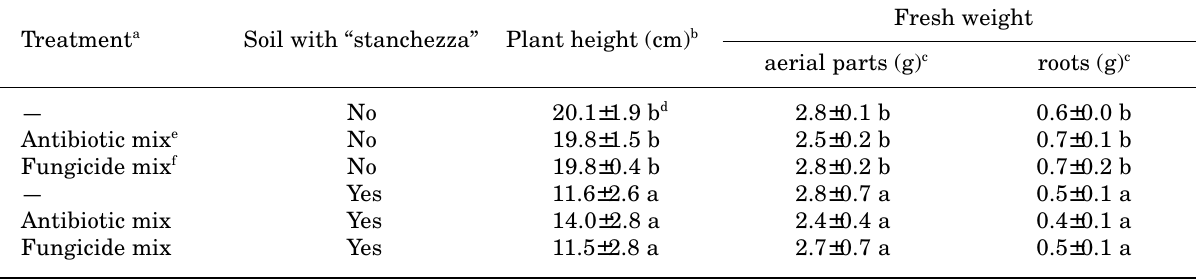
Table 5. Effect of soil treatment with two fungicide and antibiotic mixtures on “stanchezza” (soil sickness) of sweet basil. Results are expressed as plant height and f. wt. of the roots and aerial plant organs 50 days after sowing on September 30, 1998 (Trial